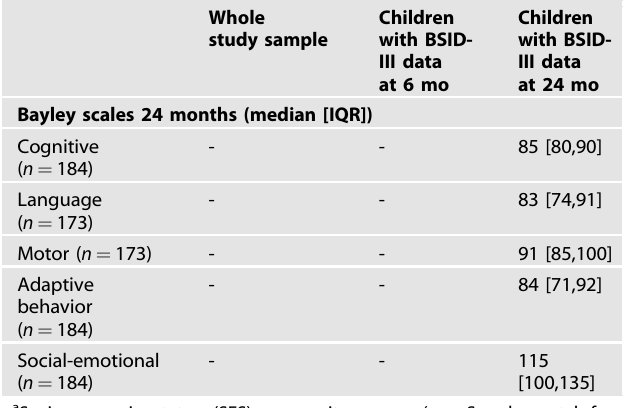
a Socioeconomic status (SES) composite scores (see Supplemental for